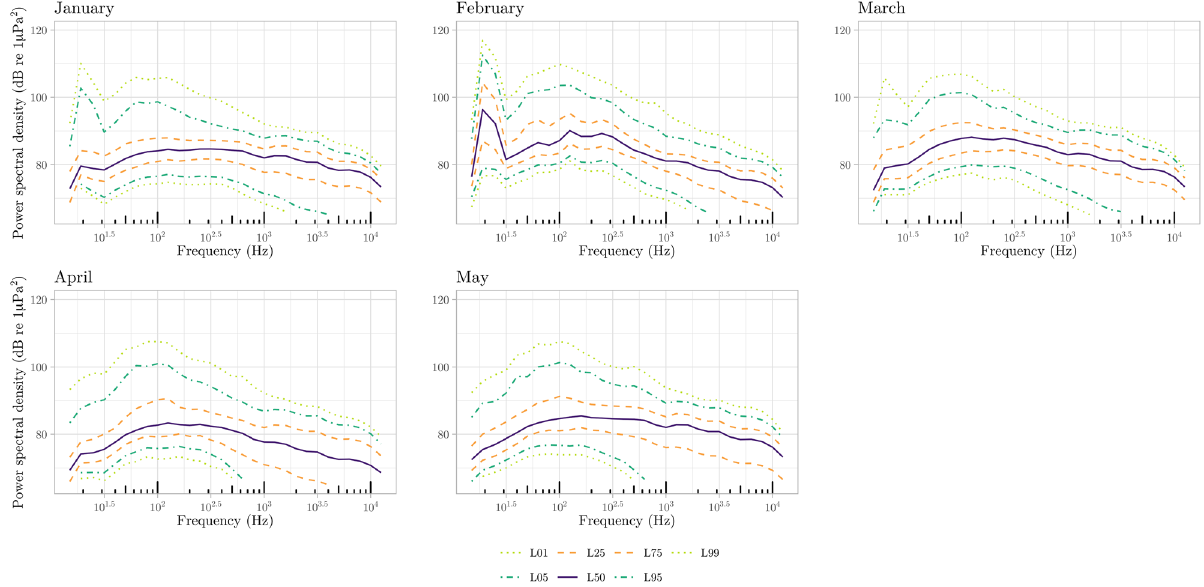
Figure 9. PSD curves with probability distribution percentiles (L01—1%, L05—5%, L25—25%, L50—50% also known as median, L75—75%, L95—95%, and L99—99%) for each month.